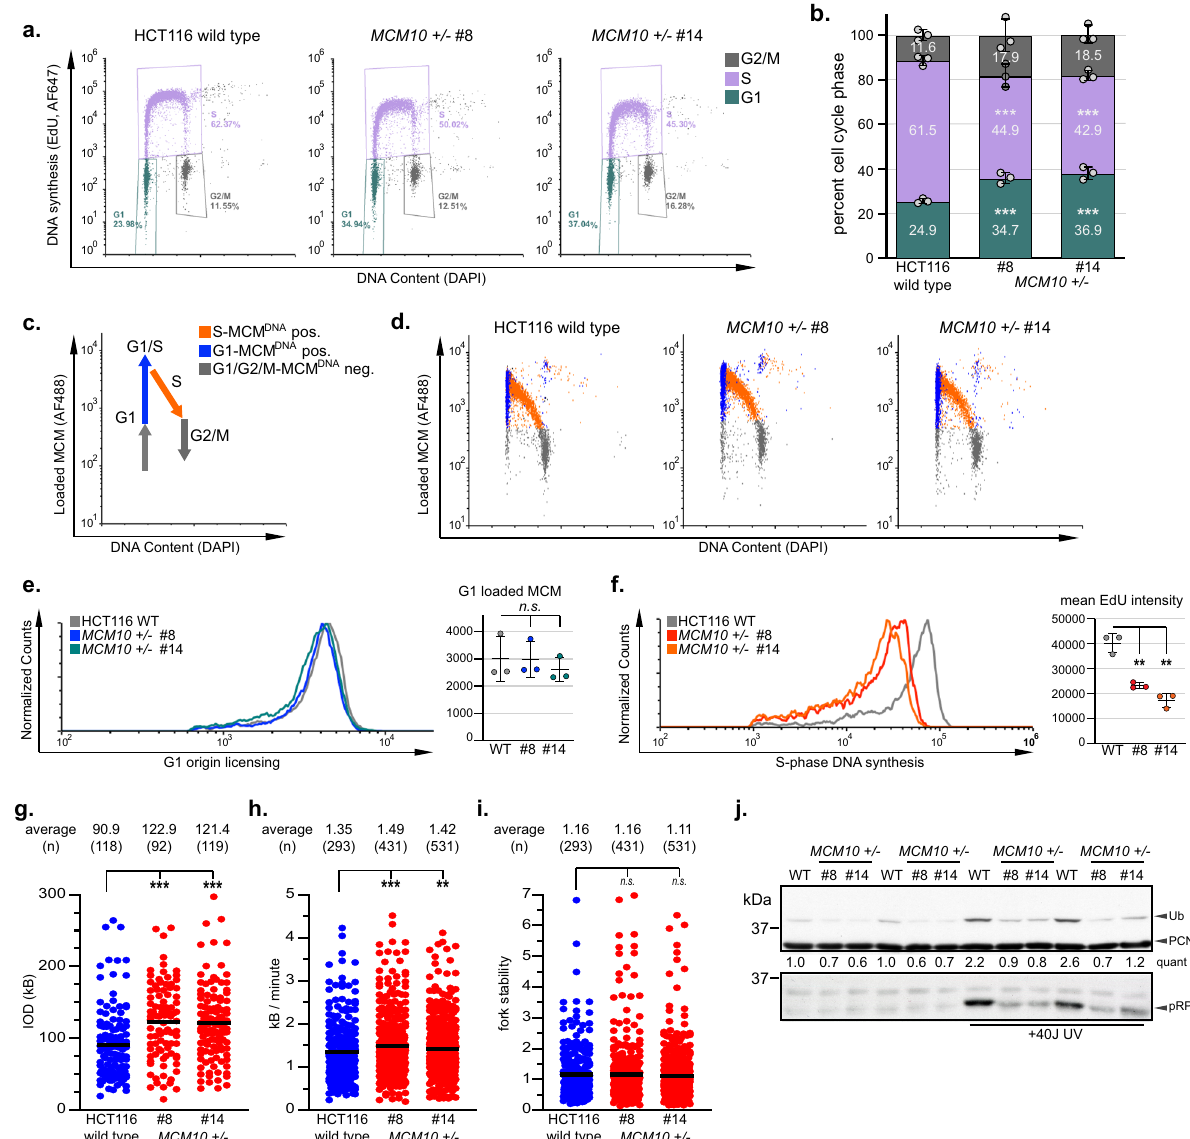
Fig. 2 MCM10 de fi ciency causes signi fi cant cell cycle and DNA synthesis defects. a Cell cycle distribution of wild type and MCM10 + /- cells. The percentage of each population in G1- (green), S- (purple) or G2/M-phase (gray) is indicated. b Cell cycle distribution of wild type and MCM10 + /- cell lines from three biological replicates. The average percentage of each population in G1- (green), S- (purple), and G2/M-phase (gray) is indicated. Individual data points are indicated (gray circles). c Schematic of fl ow cytometry analysis. Cell-cycle phase is de fi ned by DNA content, EdU incorporation, and chromatin- loaded MCM2. d Analytical fl ow cytometry plots for wild type and MCM10 + /- cells. G1-phase/MCM positive cells (blue), S-phase/MCM positive cells (orange) and G1- or G2/M-phase/MCM negative cells (gray) are indicated. e Comparison of origin licensing (left) and quanti fi cation of average G1 loaded MCM2 in biological replicates ( n = 3) of wild type (gray) and MCM10 + /- cells (blue/green). f Comparison of S-phase DNA synthesis (left) and average EdU intensity in biological replicates ( n = 3) of wild type (gray) and MCM10 + /- cells (red/orange). Error bars in b , e , and f indicate SD, and signi fi cance was calculated using an unpaired, two-tailed student ’ s t-test with *<0.05; **<0.01, ***<0.001. g Inter-origin distance (IOD) quanti fi cation in wild type (blue) and MCM10 + /- cells (red). Average IOD and number ( n ) quanti fi ed are listed. h Fork speed in wild type (blue) and MCM10 + /- cells (red). Average fork speed (kb/minute) and number ( n ) quanti fi ed are listed. i Fork stability in wild type (blue) and MCM10 + /- cells (red). Average fork stability and number ( n ) quanti fi ed are listed. Statistical signi fi cance for g – i was calculated using an unpaired, two-tailed Mann-Whitney Ranked Sum Test with *<0.05; **<0.01, ***<0.001. j Chromatin associated PCNA, PCNA-Ub, and phospho-RPA32, which binds to ssDNA exposed during replication stress, with and without 40 J UV treatment. Quanti fi cation of PCNA-Ub levels normalized to unmodi fi ed PCNA, relative to the fi rst lane wild type sample is indicated. Source data for panels b , e , f , g , h , i , and j , including relevant exact p-values, are provided in the Source Data fi and MCM4 + /- mutants (Supplementary Fig. 4e, f). Taken toge- ther, these data argue that HCT116 cells are sensitive to inacti- vation of one CDC45 or MCM4 allele, but they are signi fi cantly more sensitive to MCM10 heterozygosity which is associated with a unique telomere maintenance defect.